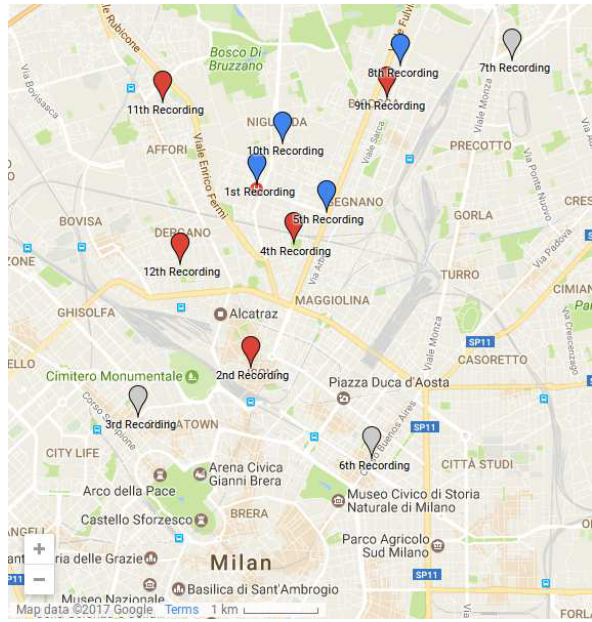
Figure 4: Recording campaign sites of the Milan urban area.